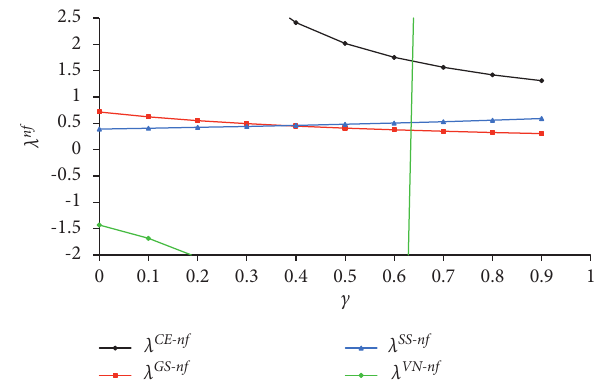
Figure 5: Effects of c on distribution radio.